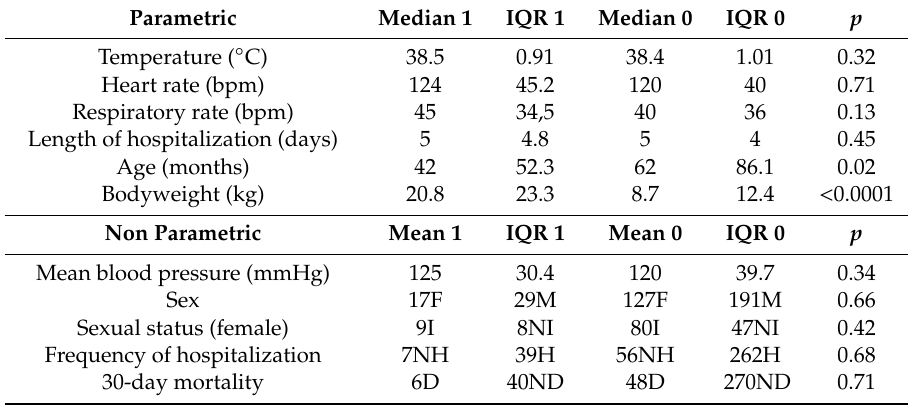
Table 2. Comparison of risk factors for lung laceration between group 1 (dogs with lung laceration) and group 0 (control group). Female (F), male (M); intact (I), non-intact (NI). Non-hospitalized (NH); hospitalized (H). Death (D); non-death